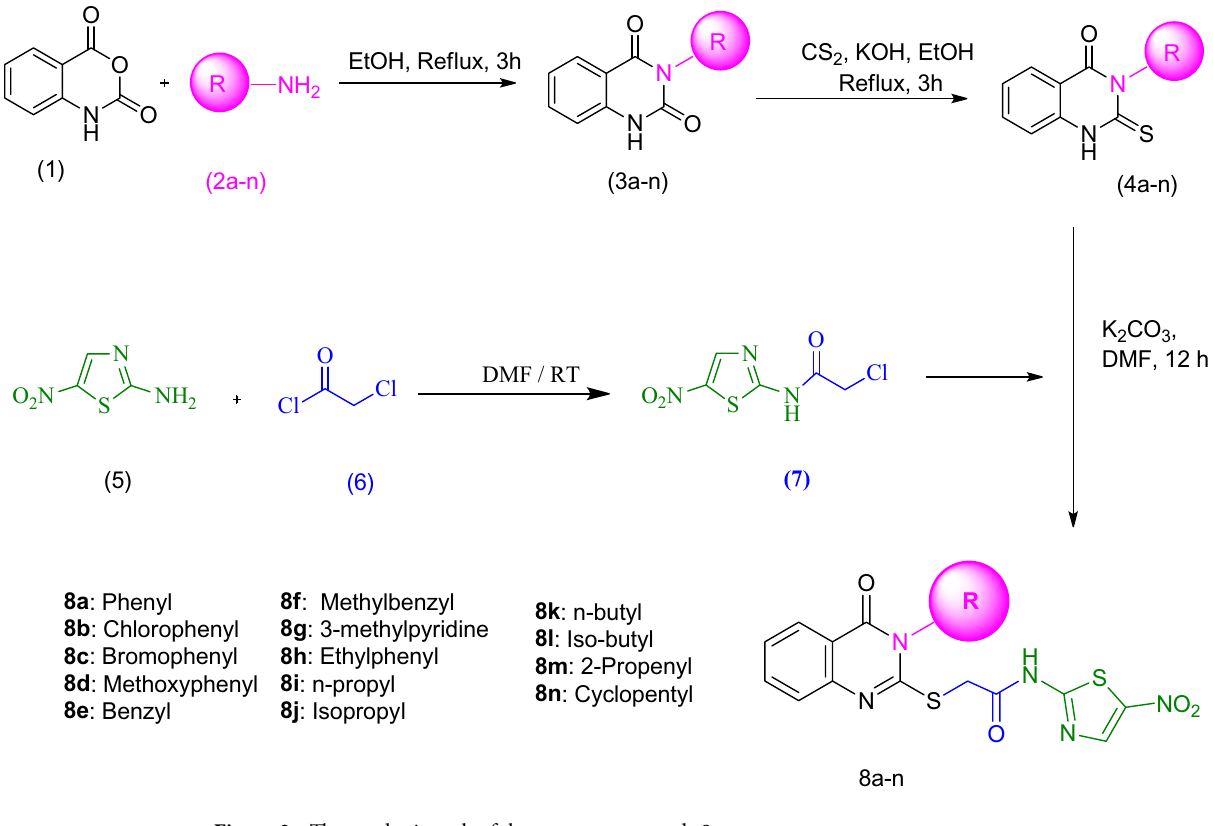
Figure 2. The synthetic path of the target compounds 8a-n